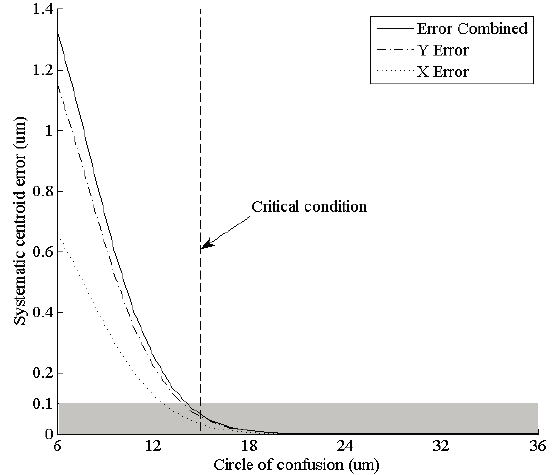
Figure 11. Systematic centroid error at (0.8 μ m, 1.4 μ m) under different circles of